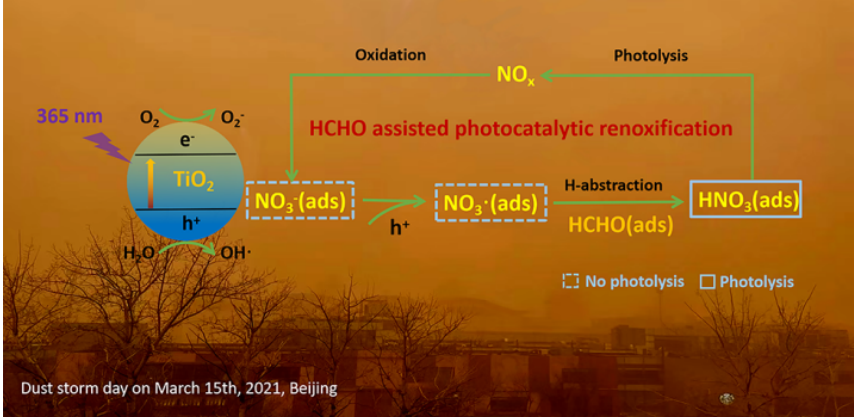
(cid:113) –HNO 3 –NO x